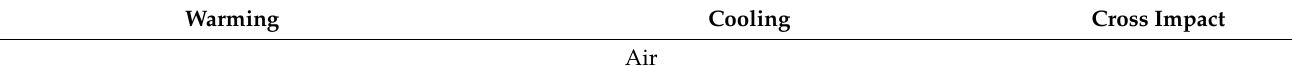
Table 2. The summary of the warming and cooling effect of NO x in terms of the influence on the